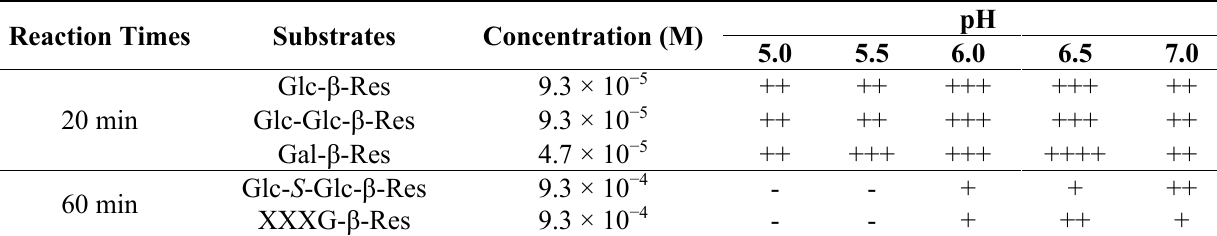
Table 1. Optimal reaction conditions (reaction times, substrate concentrations) for the signal strength and dependence of the signal strength on pH for the different glycoside resorufin substrates in Arabidopsis stem